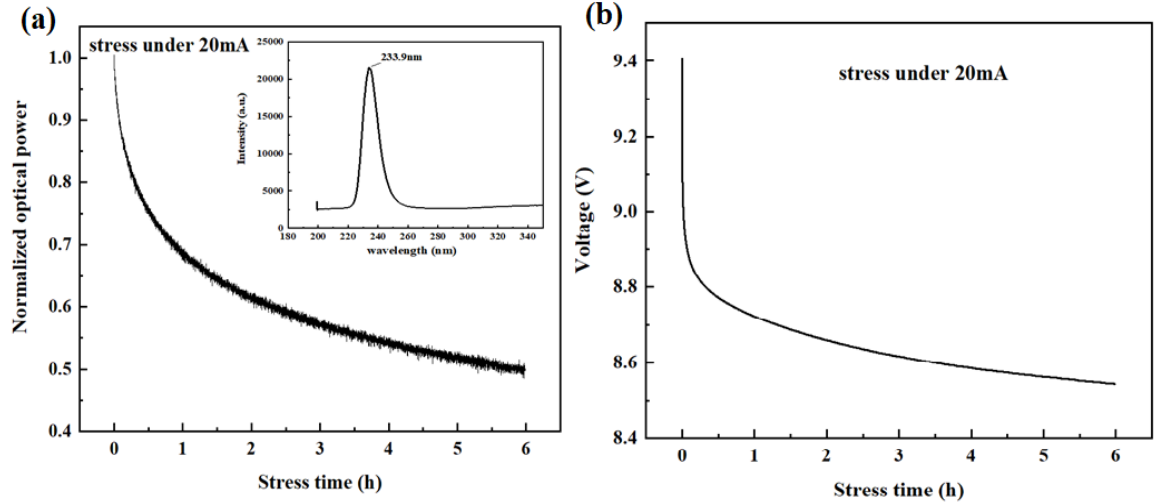
Figure 34. ( a ) Variation of optical power with aging time for 234 nm DUV LED at 20 mA current. Inset is the EL spectrum at 10 mA current, ( b ) The I-V curve under stress of 20 mA.